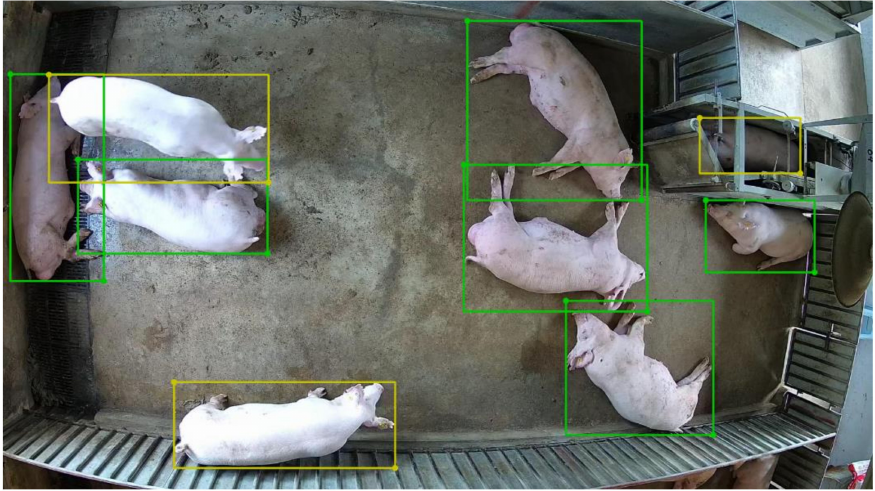
Figure 1. Annotated example for posture detection (the yellow bounding box represents the standing pig, and the green bounding box represents the lying